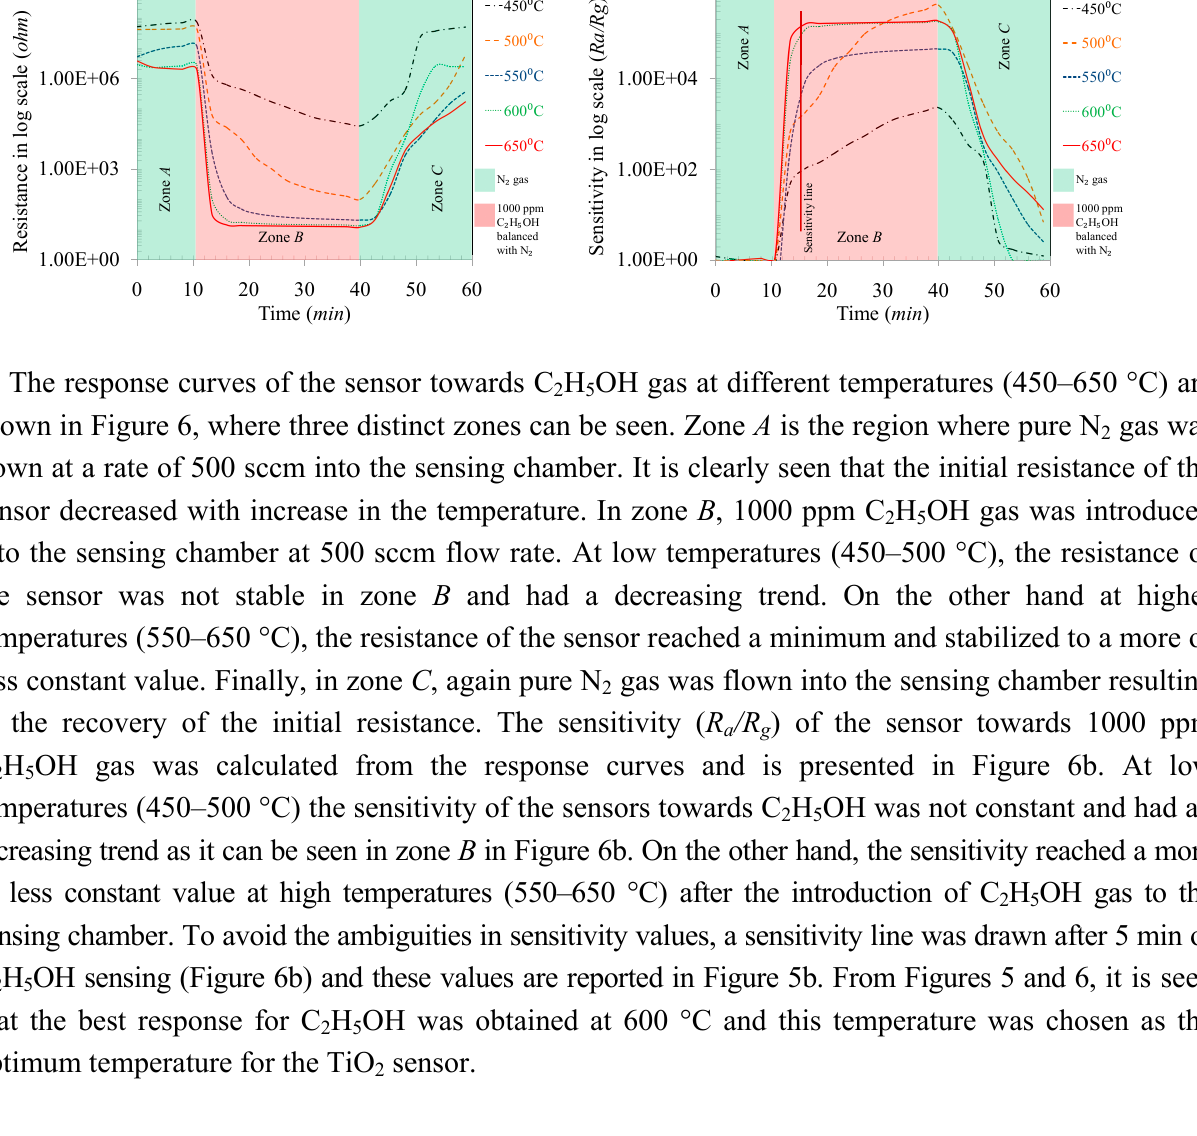
nanoparticles towards 1000 ppm C 2